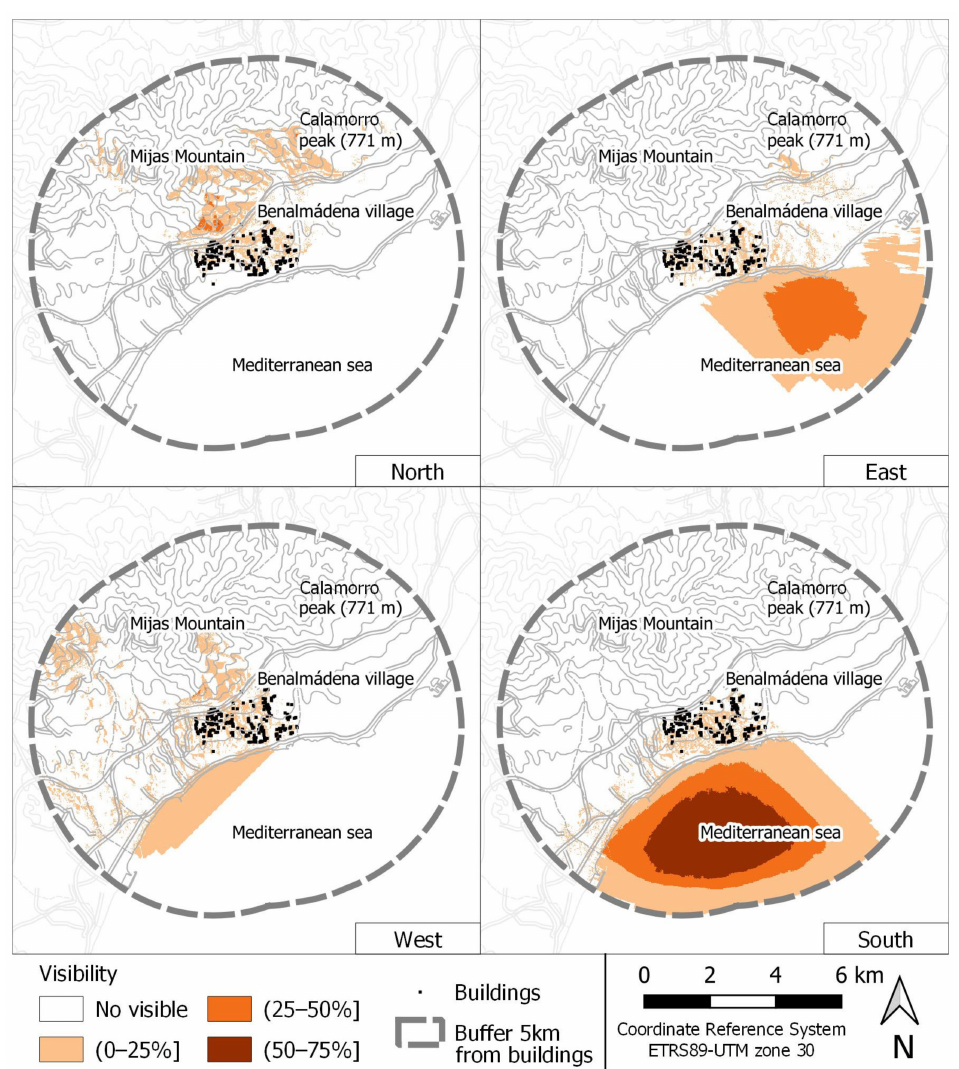
Figure 6. Areas of greater visibility from points selected at each cardinal point (own